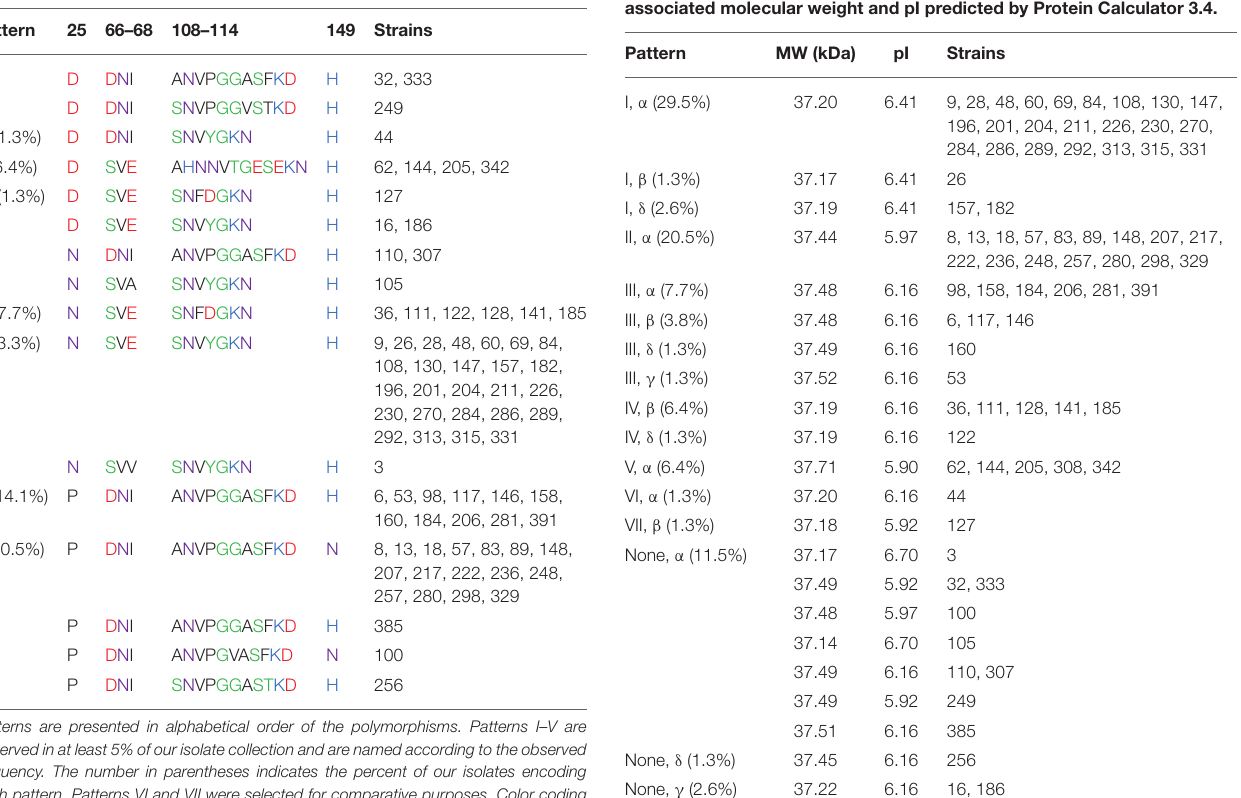
The number in parentheses indicates the percent of our isolates encoding the indicated